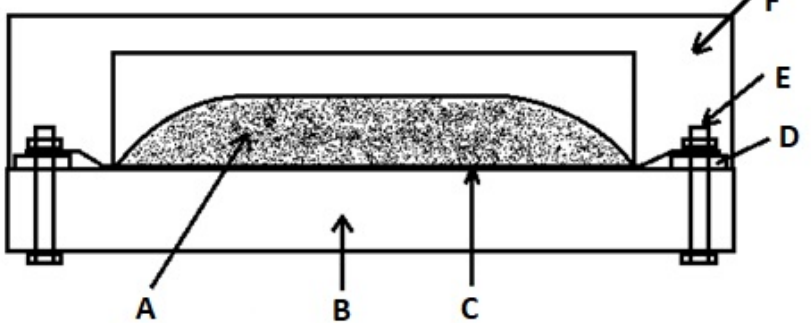
Figure 1. Schematic of the reactor setup. ( A ) powder bed, ( B ) high temperature brick, ( C ) graphite foil boat, ( D ) copper contact electrode, ( E ) mounting screw and nut, ( F ) insulating wool.